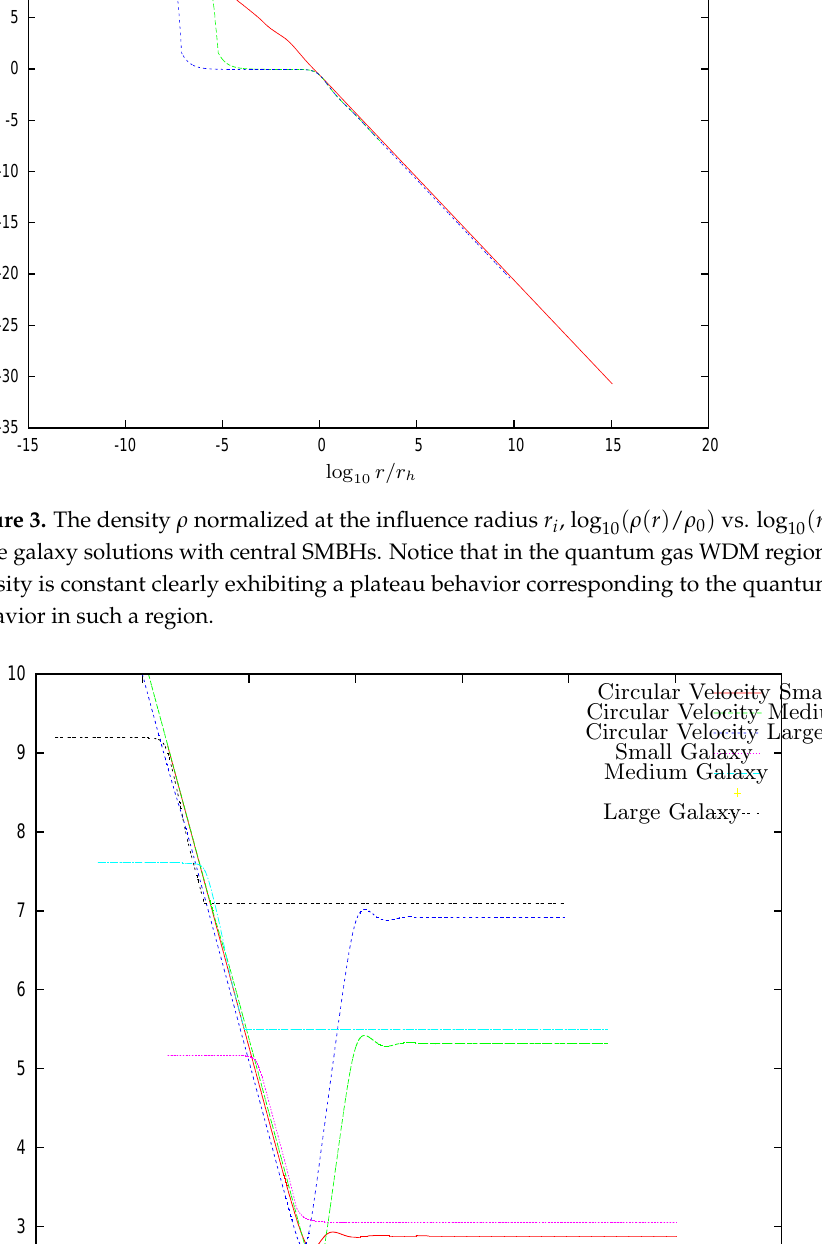
Figure 4. The velocity dispersion < v 2 > ( r ) and the circular velocity v 2 c ( r ) for the three representative galaxy solutions with central SMBH vs. log ( r/r h ). The velocity dispersion is constant in the Boltzmann and in the quantum regions indicating a thermalized WDM with two different temperatures T 0 = 1 m < v 2 > ( r ). For r > r h the circular velocity tends to the velocity dispersion [13]. These results are in agreement with the DM thermalization found in the absence of a central BH [13], [12].